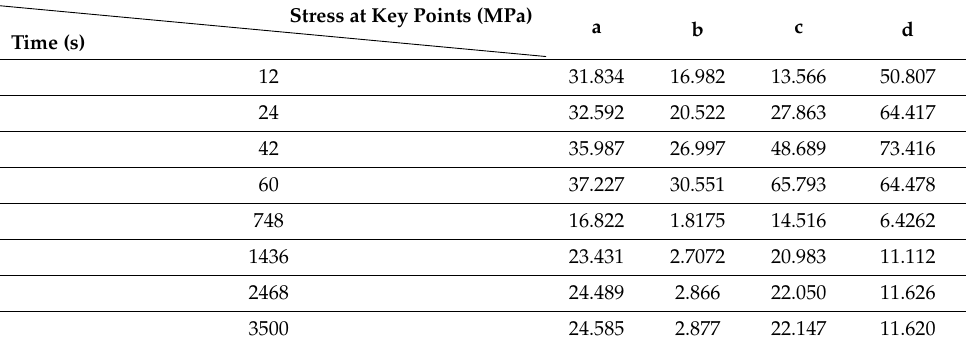
Figure 12. Comparison of the stress for the two types of constraints: 1: the first constraints; 2 the second constraints.